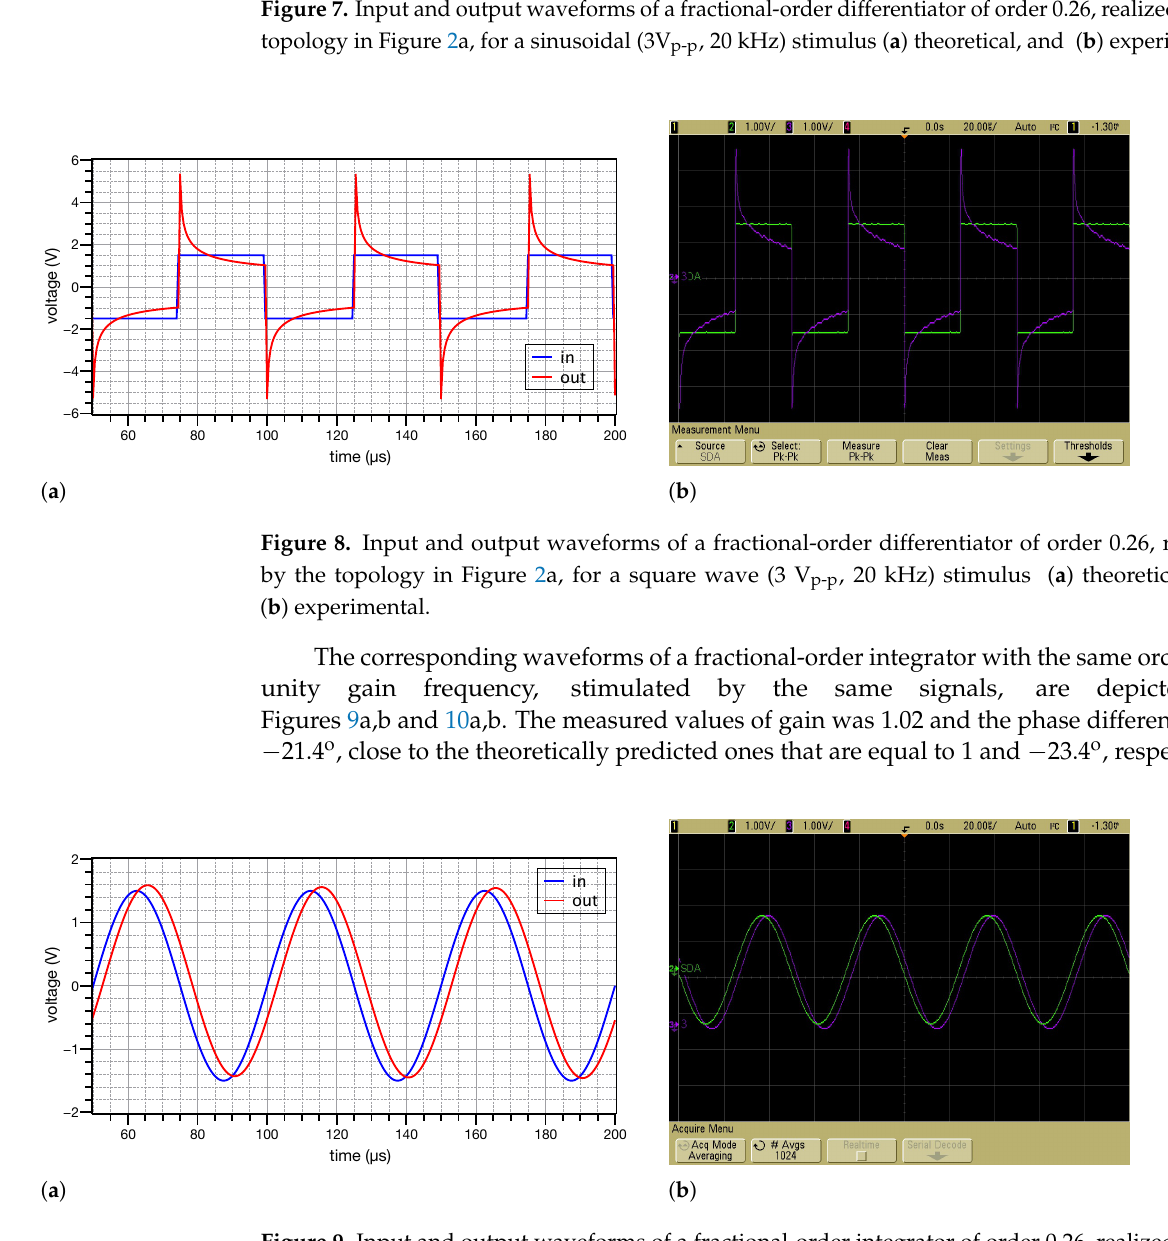
Figure 9. Input and output waveforms of a fractional-order integrator of order 0.26, realized by the topology in Figure 2b, for a sinusoidal (3 V p-p , 20 kHz) stimulus ( a ) theoretical, and ( b )